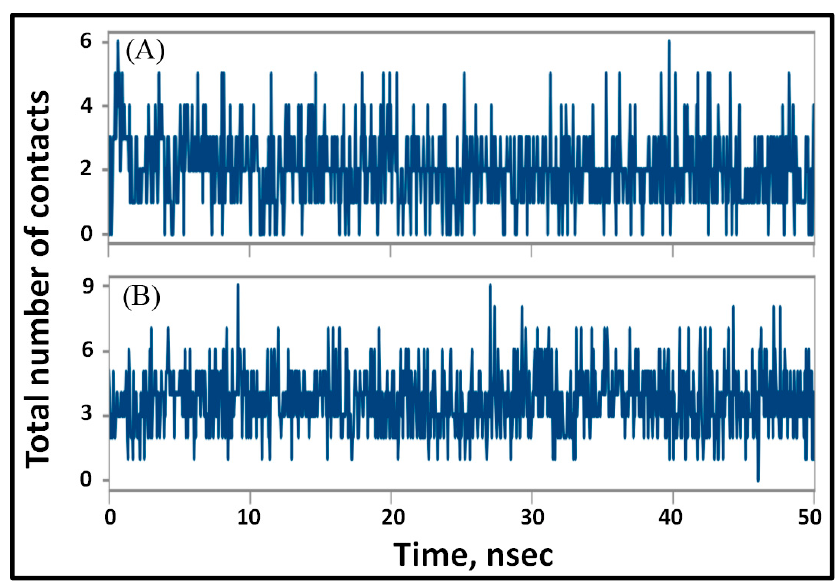
Figure 6. Variation in the total number of contacts formed between PLK-1 and ( A ) compound 1 , and ( B ) PHA680626, as a function of simulation time. function of simulation